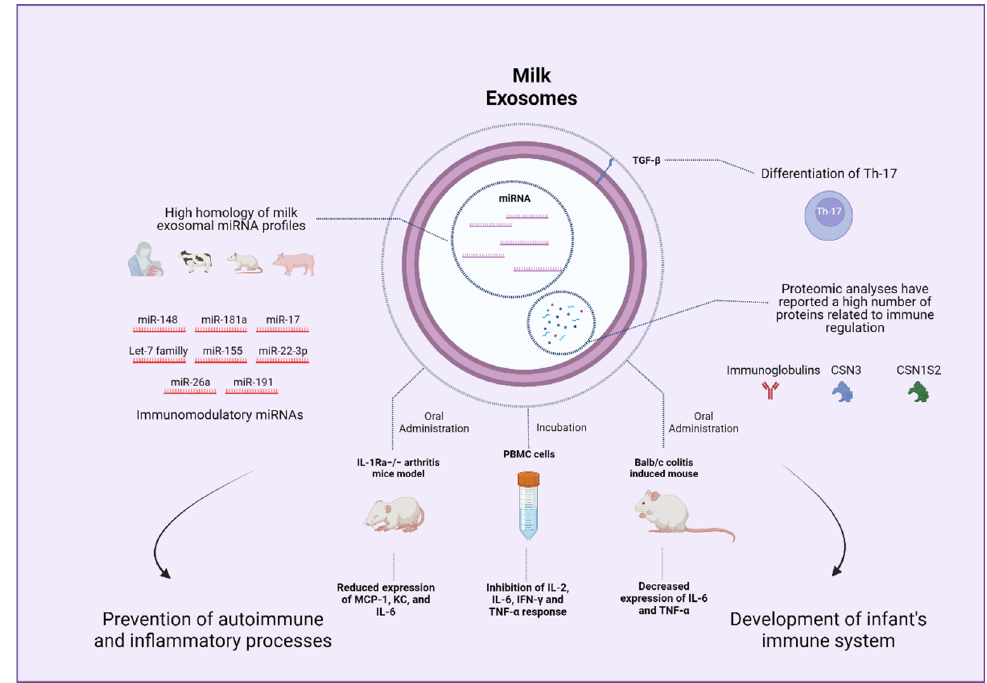
Figure 5. Potential beneficial effects of milk exosomes on the immune system.